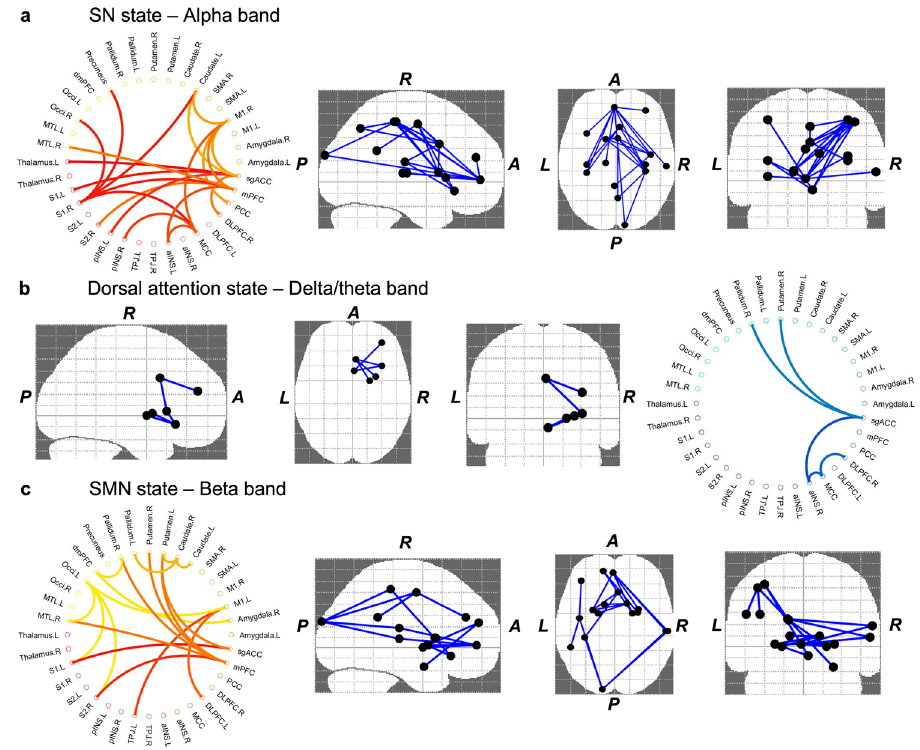
Fig. 4 Coherence changes in individuals with neuropathic pain compared to HC group in speci fi c frequency ranges. The brain maps show connections (in blue) associated with signi fi cant changes between neuropathic pain and healthy control groups in one brain state; each dot (black) represents one brain region. In the circular coherence plots, blue and red/yellow colors re fl ect respectively coherence that is lower and higher in neuropathic pain than in the control group. In neuropathic pain patients, we found that the coherence was a higher in the salience (SN; left: S1, pINS, aINS, thalamus, caudate, mPFC, MCC, sgACC; right: DLPFC, M1, medial temporal lobe (MTL), pINS, S1, posterior cingulate cortex (PCC), Precuneus, occipital lobe) state in the alpha band; and b in the sensorimotor (SMN; dmPFC, mPFC, sgACC, MTL, pallidum, putamen, caudate Left: occi, TPJ, S1, M1, DLPFC, right: amygdala, S2) state in the beta band, c whereas coherence was lower in the dorsal attention state (sgACC, MCC; right: aINS, DLPFC, pallidum, putamen) in the delta/theta compared with healthy control. * P < 0.01, corrected 5000 permutations, network-based statistic